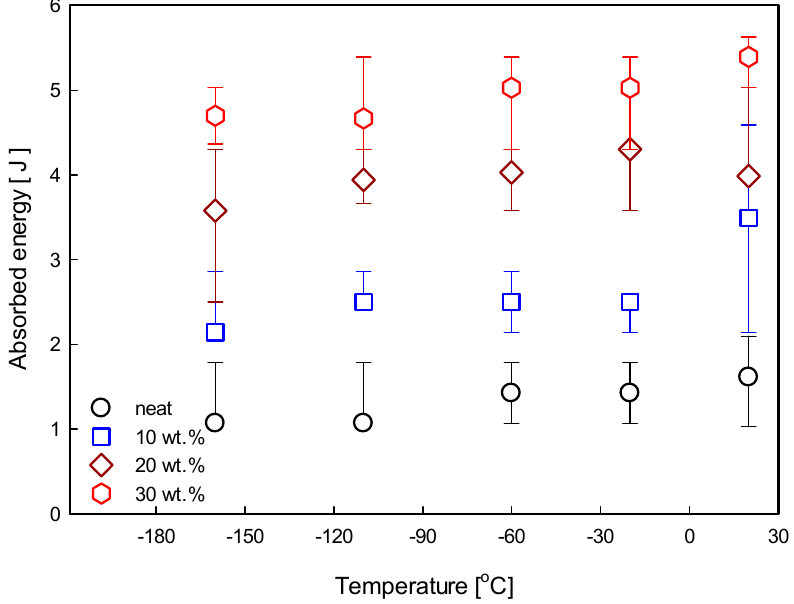
Figure 5. DBTT for glass-fiber-reinforced DCPD (GF/DCPD) composites with different weight fractions.